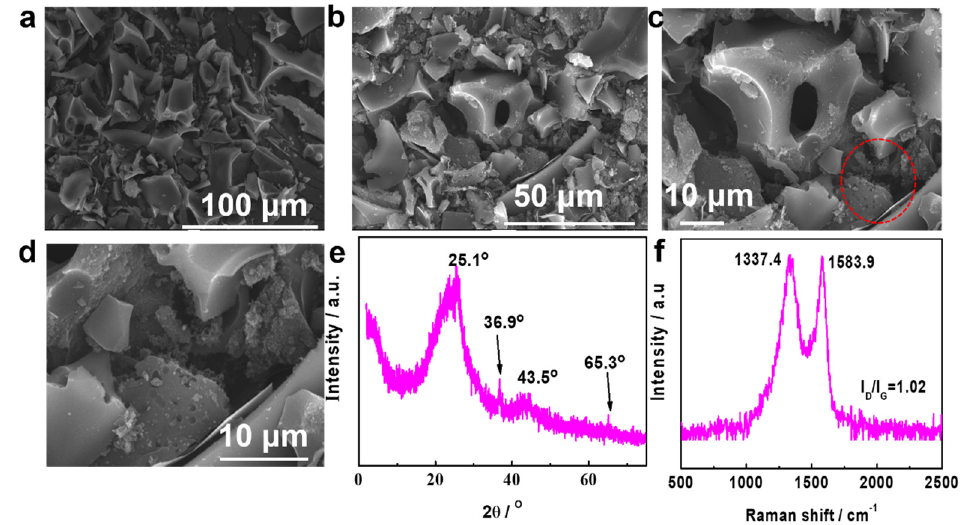
Figure 2. ( a – d ) SEM images at various magnifications for Co/N-C-900 ( d presents enlarged image of the part in the red circle of c ), ( e ) XRD pattern, ( f ) Raman spectra.